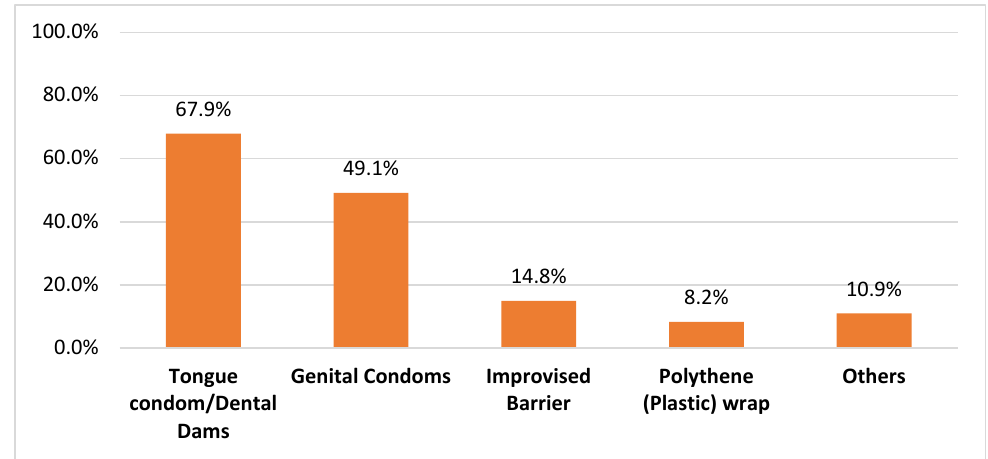
9 Table 4. Attitudes and practices related to current and future consultations on oral sex. Questions